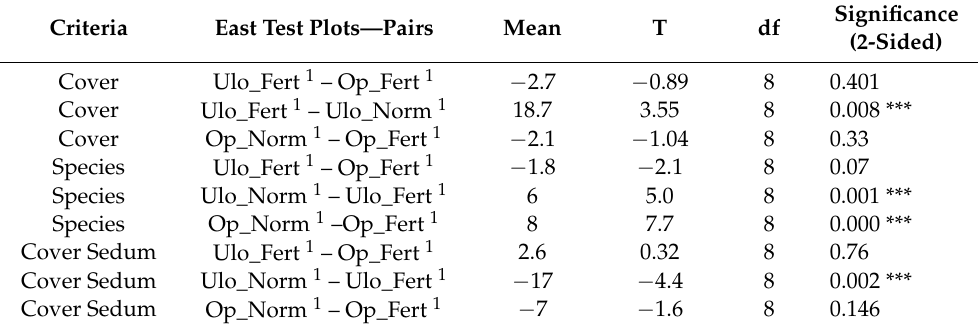
Table 11. Greening with sedum cuttings, n=9 years, from 2011 to 2020 (df 8), coverage and number of species for the test plots with fertilizer (Fert.) and without (Norm.) of the eastern position. Pairwise T and the level 1‰ of significance differences between fertilized and non-fertilized plots in relation to cover values on Ulo. The minus symbols in relation to the Sedum cover; a reduction of these plants in relation to other plants.